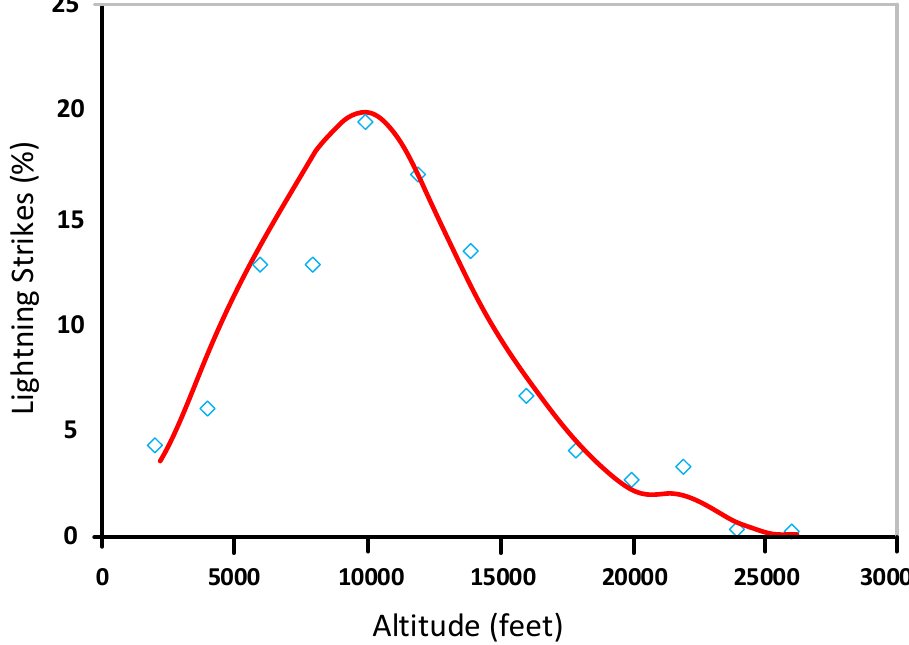
Figure 5. Lightning activity probability variation with altitude [33]. Table 6. Classification of sites regarding elevation and slope.